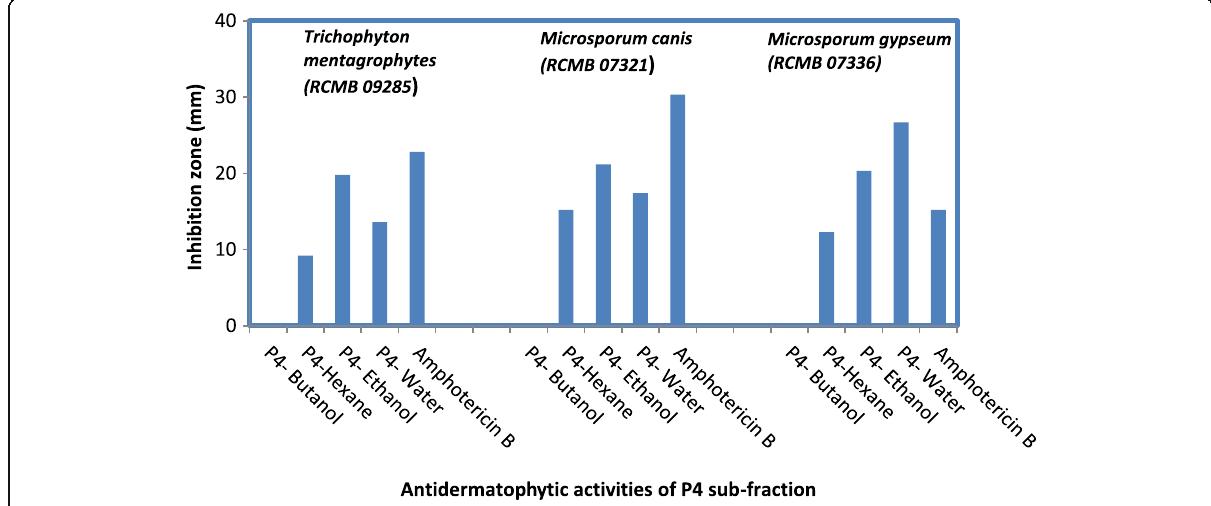
Fig. 3 Antidermatophytic activity of subfractions from liquid-liquid partition using well diffusion